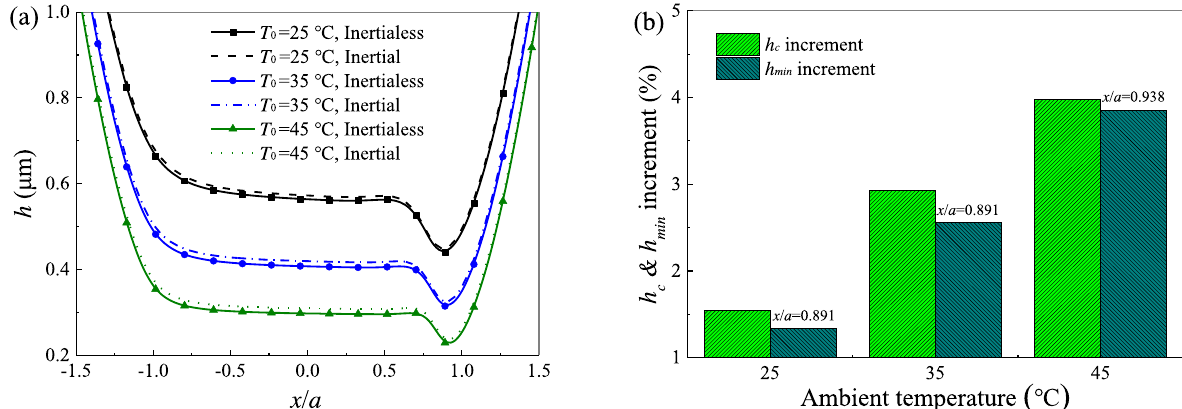
Fig. 18. Film thicknesses with inertia force at varied ambient temperature: (a) fi lm thickness, and (b) maximum relative percentage of fi lm